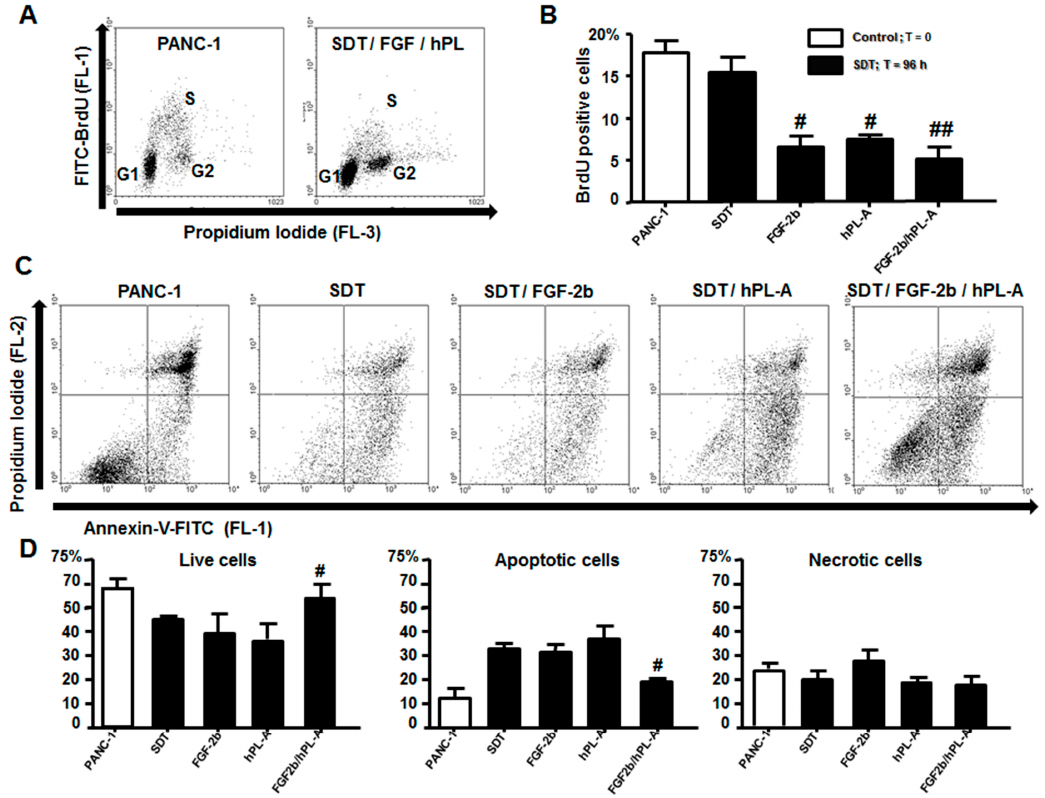
Figure 6. Islet-like aggregates were analyzed for bromodeoxyuridine (BrdU) incorporation and apoptosis. PANC-1 cells were treated with 50% trypsin for 30 s. and incubated with serum-free medium supplemented with 0.1% BSA plus 1.1 mg/L transferrin (SDT). SDT medium was then supplemented with 500 ng/mL FGF-2b or 500 ng/mL hPL-A, or both hormones (FGF-2b plus hPL-A). After 96 h of treatment, islet-like aggregates were incubated for additional 20 min. with BrdU. Then, aggregates were harvested, disaggregated to form a single cell suspension and immediately analyzed using FACS. ( A ) Typical dot plots are shown: note the decrement in the BrdU-positive (S-phase) cell number induced with FGF-2b plus hPL-A treatment. ( B ) The percentages of S-phase cells after 96 h of incubation are shown. # p < 0.05 and ## p < 0.01 vs. SDT; n = 4 (four separate experiments). For the analysis of apoptosis, the single cell suspensions were incubated with annexin-V-FITC and propidium iodide, and immediately analyzed with FACS. In the dot plots ( C ), we can identify live cells (low left quadrant), apoptotic cells (low right quadrant), and necrotic cells (upper quadrants). ( D ) The percentages of live, apoptotic and necrotic cells are shown. # p < 0.05 vs. SDT; n = 4 (four separate